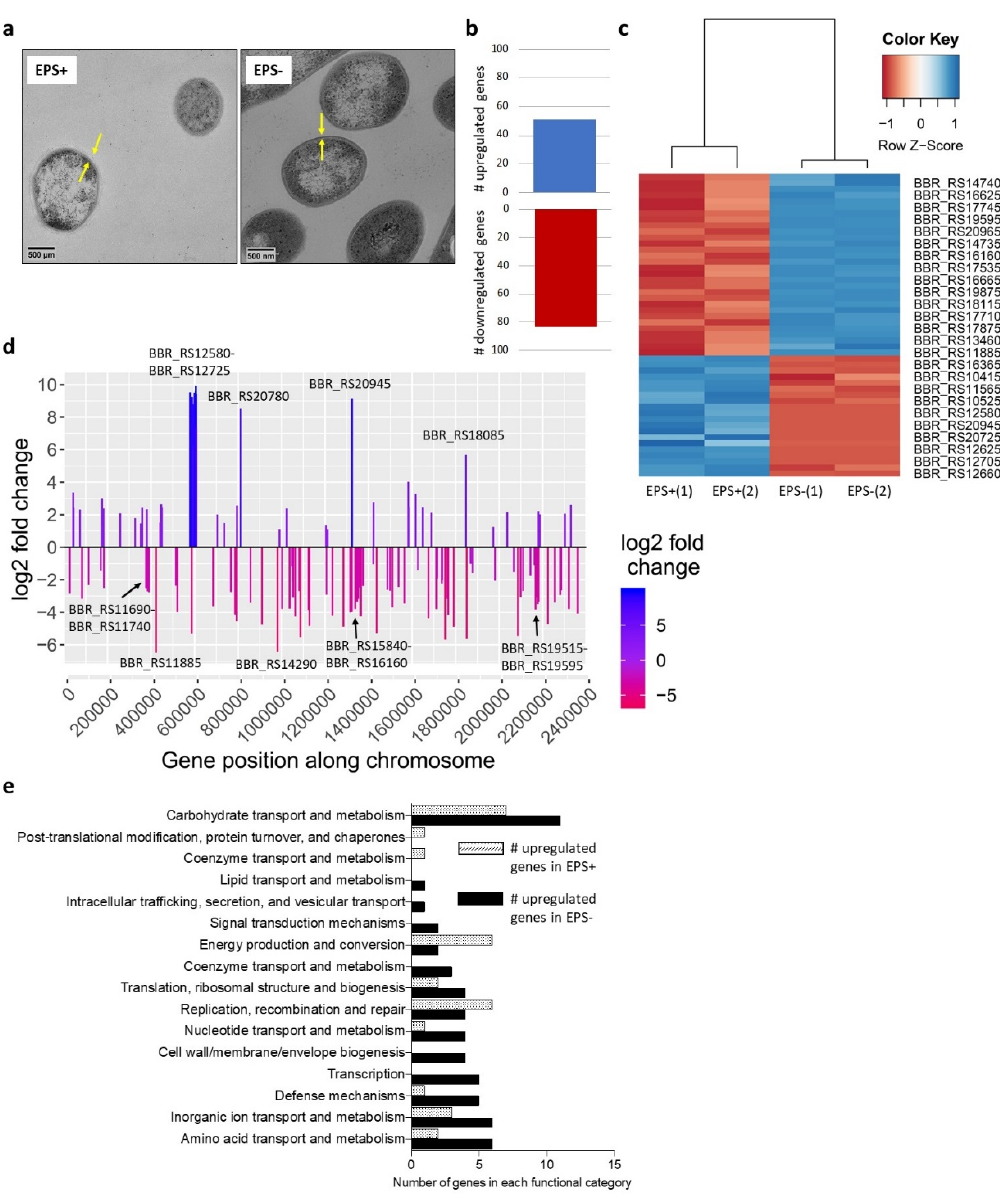
Figure 1. Characterization of EPS ‐ mediated B. breve modulation. ( a ) TEM of B. breve UCC2003 (EPS+) and B. breve UCC2003del (EPS − ). Arrows note the EPS layer. ( b ) Total number of differentially expressed genes when comparing EPS+ to EPS − conditions, (two independent experimental repeats). ( c ) Top 50 differently expressed genes with an absolute log2 fold change ≥ 1 and p adj value ≤ 0.05. Hierarchical clustering of samples. Significance based on adjusted p value. ( d ) Bar plot of EPS+ vs EPS ‐ differential gene expression (absolute log2 fold change ≥ 1 and p adj value ≤ 0.05) across the genome with gene name labels. ( e ) Number of differentially expressed genes in each functional category (EPS+ vs EPS − ) according to EggNog mapper annotation.